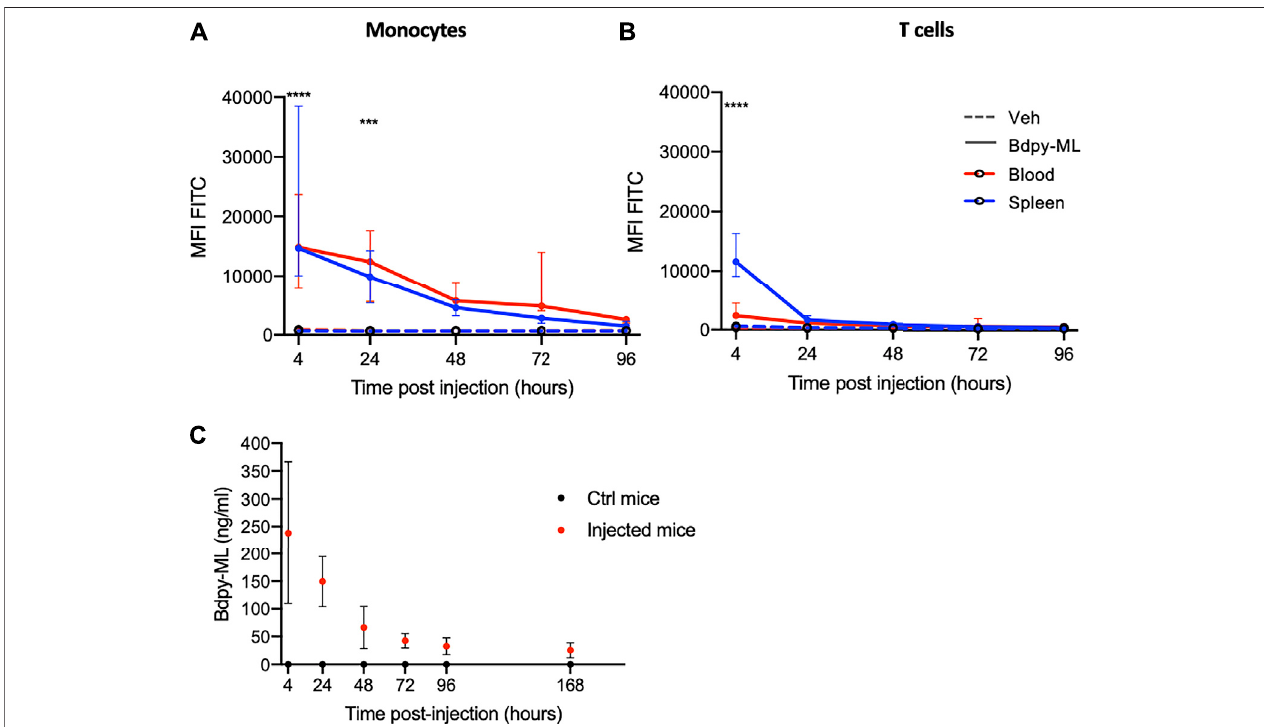
FIGURE 4 | In the mouse, intra-venously delivered Bdpy-ML is detected in plasma up to 7 days post-injection. (A, B) Bdpy-ML incorporation, as measured by FACS,inblood(red)orspleen(blue)monocytes (A) andCD3 + Tcells (B) inmiceinjectedwitheitherBdpy-ML(plainlines)orwithvehicle(dottedlines).Dataarepresented as mean fl uorescence intensities (MFI) across time and are median values ± SD, at least 3 mice per group. (C) Estimated concentration of circulating Bdpy-ML (from standard curve) in plasma following intravenous injection. Data are median values ± SD, at least 3 mice per group. Test 2-way Anova, *** p < 0.001, **** p <